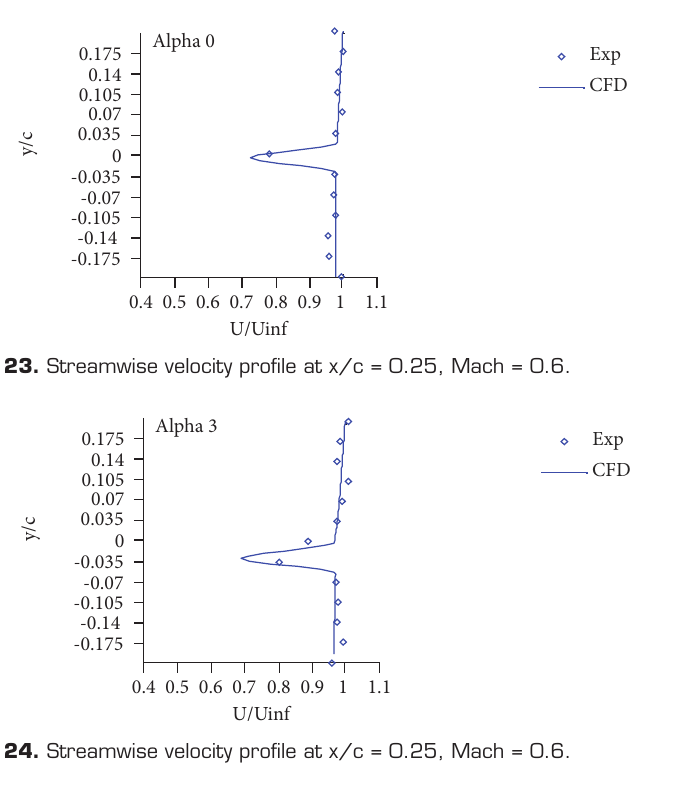
Figure 22. Streamwise velocity profile at x/c = 0.25, Mach = 0.4.